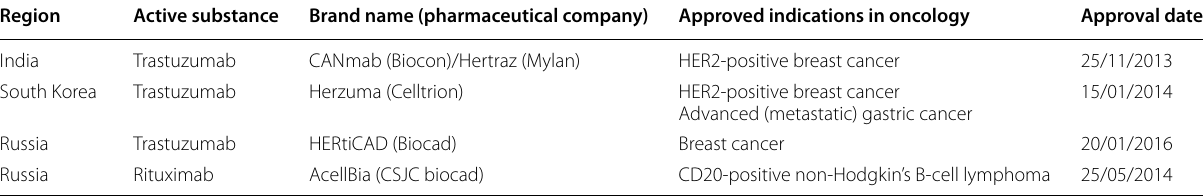
HER2 human epidermal growth factor receptor 2